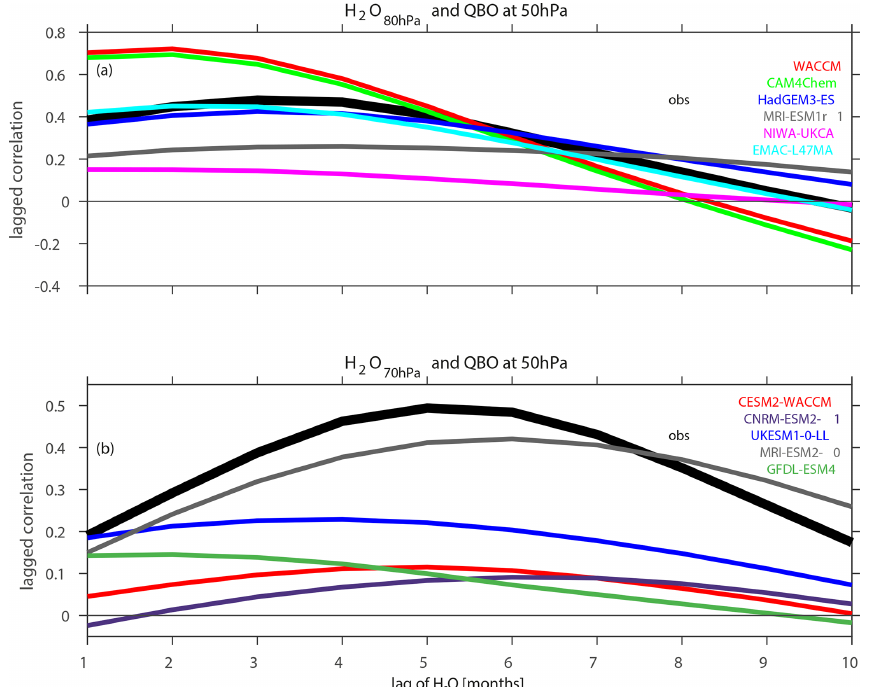
Figure 1. Lagged correlation between the QBO at 50hPa and tropical water vapor at (a) 80hPa in CCMI models and (b) 70hPa in CMIP6 models (entry water is lagged after the QBO). The lagged correlation for observations (SWOOSH data) is also included as a thick black line. The combinedanomfillanomh2oq product of swoosh-v02.6-198401-201912-latpress-2.5deg-L31 is used for observations from 1994 to 2019. Note that the WACCM, CAM4Chem and EMAC-L47MA models in panel (a) nudge the QBO; in all other models, the QBO is spontaneously generated.